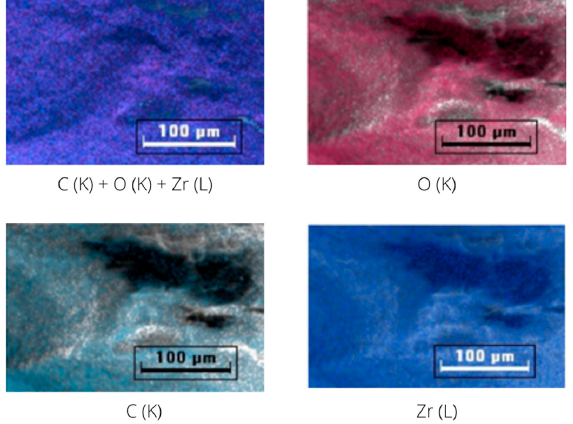
Figure 6. EDX mapping of UiO-66.